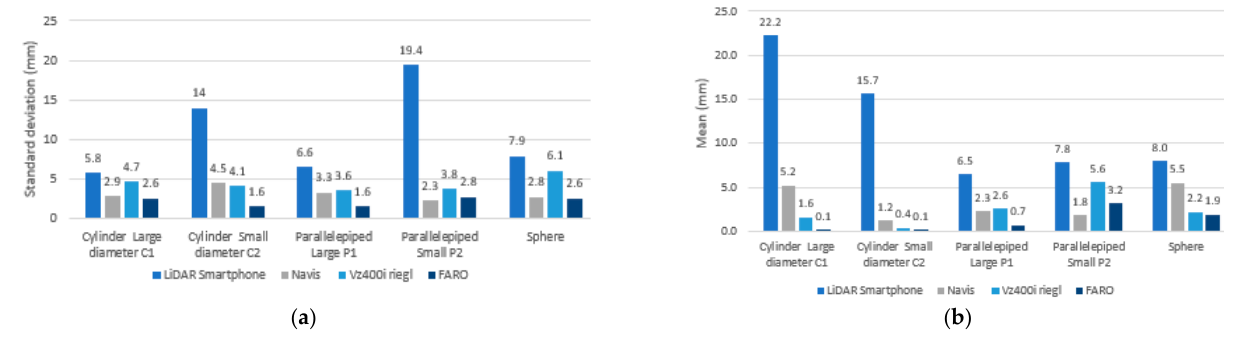
Figure 13. ( a ) Cloud–primitive distance standard deviation diagram of the 4 scanners in situ on geometric primitives. ( b ) Diagram of the mean distance Cloud–primitive of the 4 scanners in situ on geometric primitives on geometric primitives.